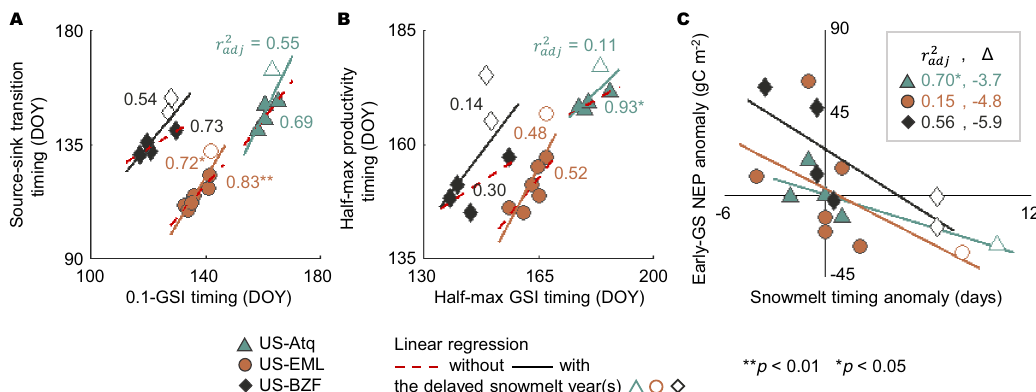
Fig. 3 Changes in fl ux timing and magnitude due to delayed snowmelt. At three sites (US-Atq, US-EML, and US-BZF), A , B correlations between fl ux timings (source-sink transition timing and half-max productivity timing) and meteorological timings (0.1-GSI timing and half-max GSI timing) with and without the delayed snowmelt year(s) (empty markers), and C decreases in the early growing season net ecosystem productivity (early-GS NEP) by snowmelt timing delay ( Δ higher latitudes ( r = 0.82, p < 0.05, Fig. 2C); however, no such correlation was found for the P winter trends with latitude across